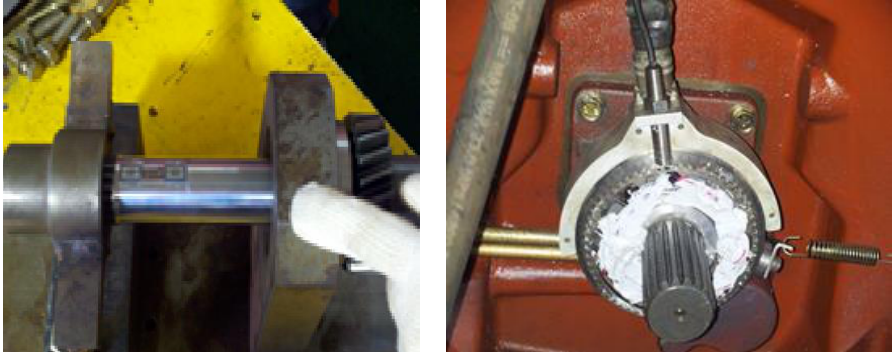
Figure 15. Strain gages and pick-up sensor installed on input shaft.